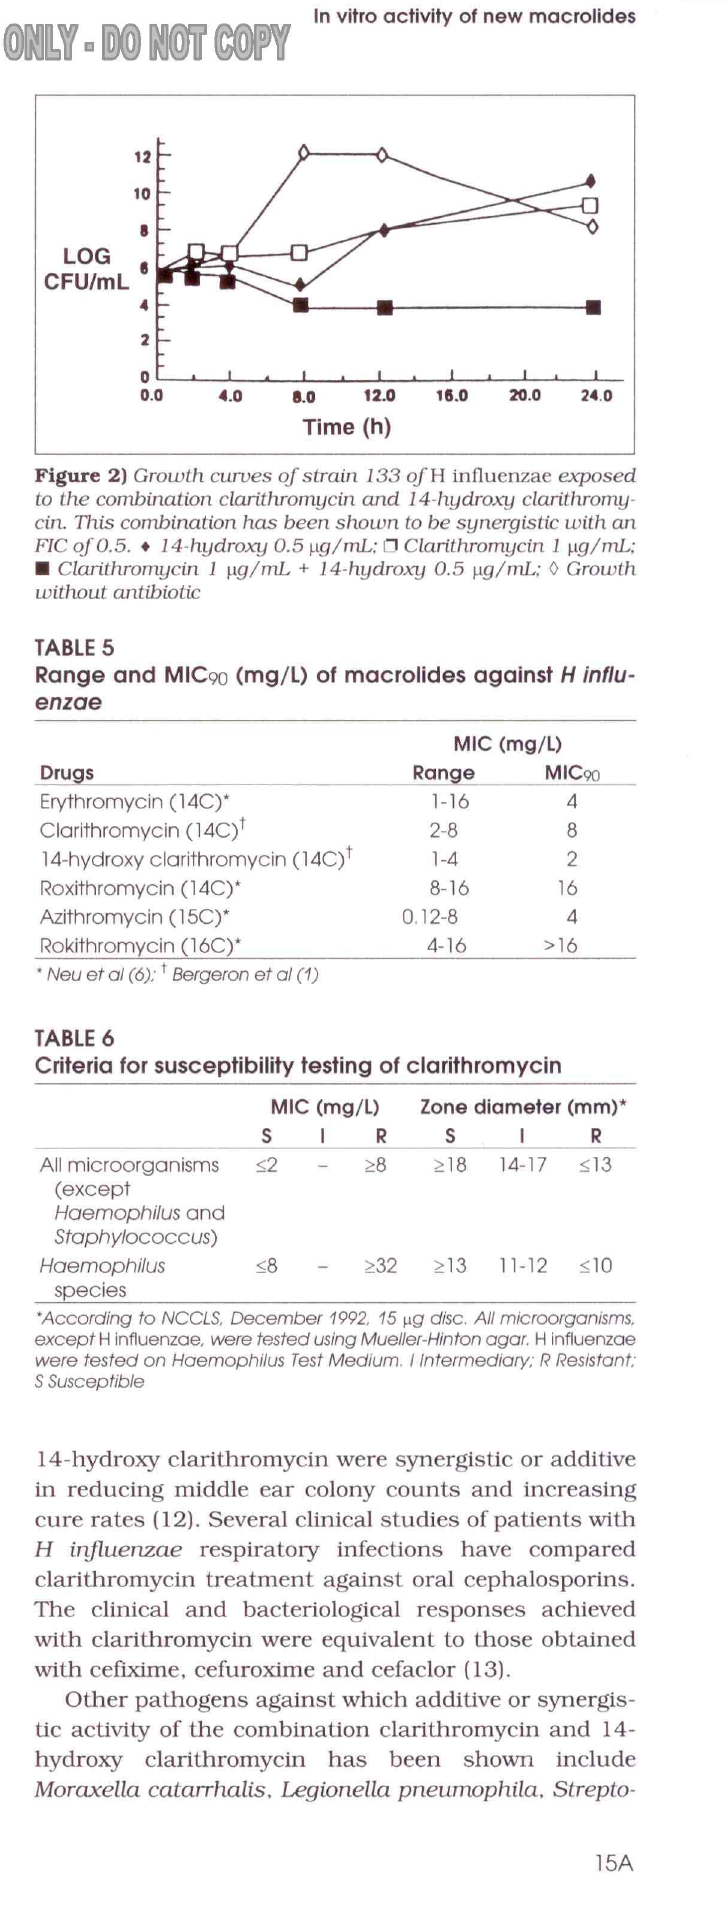
• Neu eta/ (6): t Bergeron eta/ (1) TABLE 6 Criteria for susceptibility testing of clarithromycin MIC